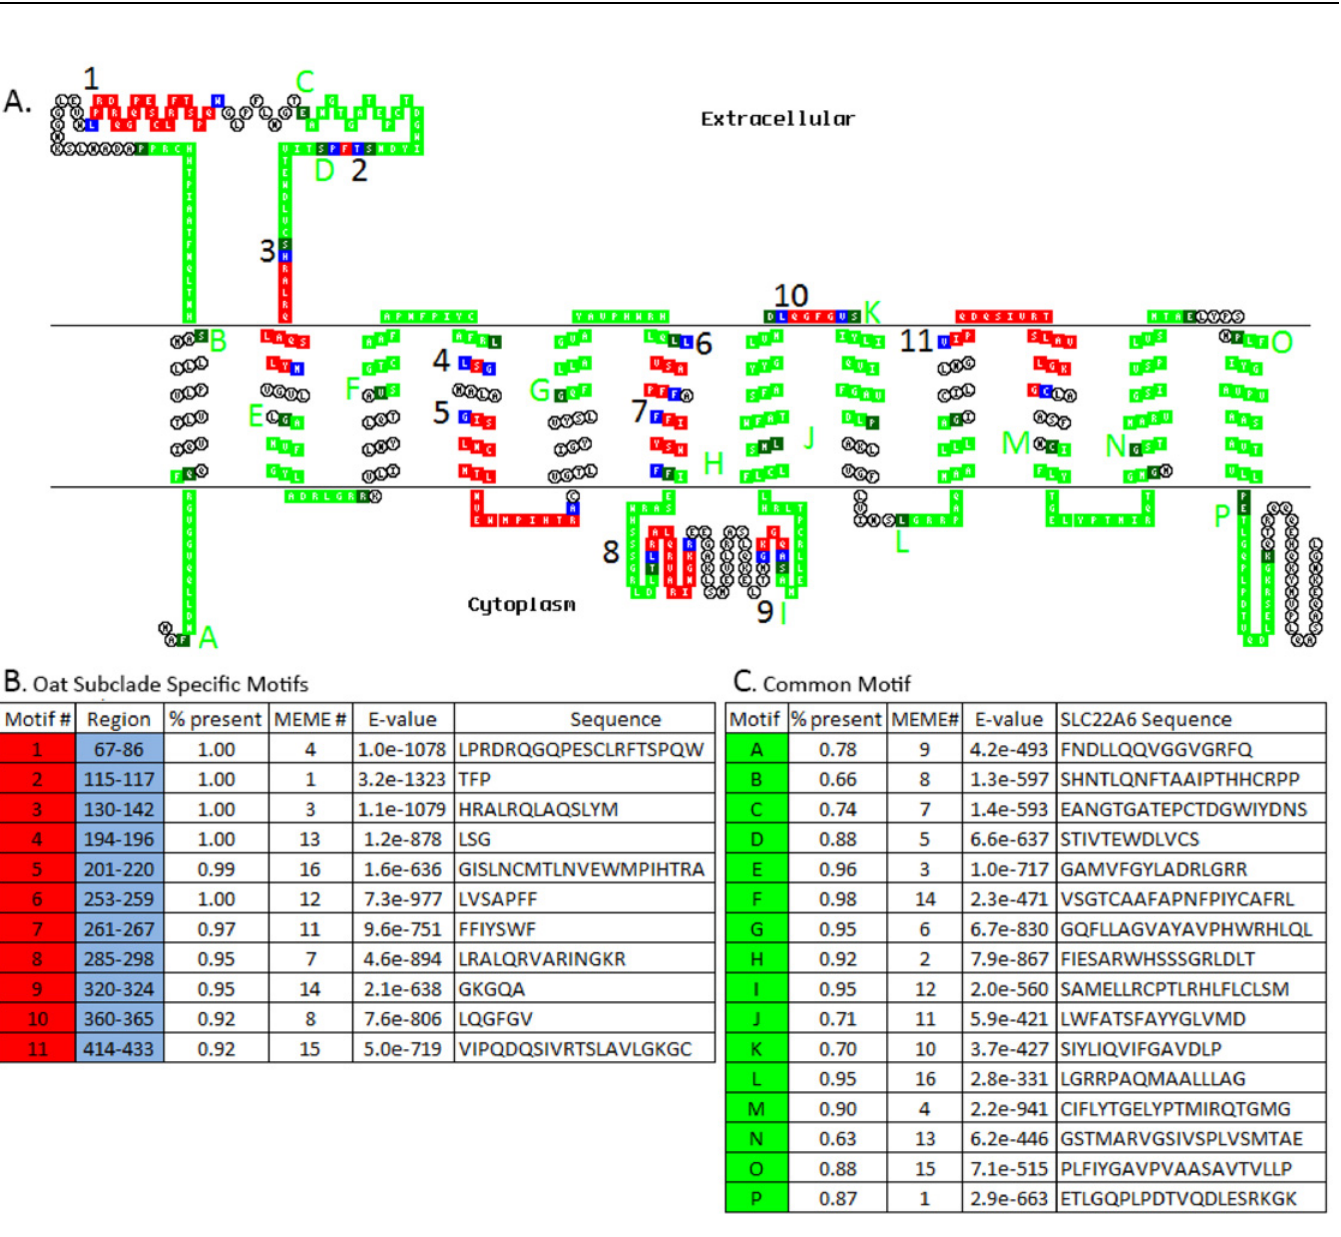
Fig 3. Overlay of Common and Subclade-specific Motifs on Human SLC22A6 2D Topology. (A) SLC22 family-conserved motifs versus subclade- conserved motifs. Overlaid on the 2D topology are the 16 evolutionarily-conserved family motifs (green/dark green) and the 11 subclade-specific motifs (red/ blue). Conserved family motifs are assigned letters A-P in the order of appearance in human OAT1 (human SLC22A6). Subclade-specific motifs are either whole or partial (red/blue) and are assigned the numbers 1 – 11. (B) This table describes the order, region, and percent present of the motifs which appear in the inputted set, MEME#, E-value, and amino acid sequence of each of the subclade-specific motifs identified for the hOAT1 sequence (red). (C) This table describes the SLC22 family-conserved motifs that have been overlaid onto the hOAT1 sequence (green). It lists the motif letter and percent present in all 111 sequences used in the MEME analysis, the MEME#, E-value, and the amino acid sequence of hOAT1 associated with the particular motif letter. Additional sequence information can be found in S3 and S4